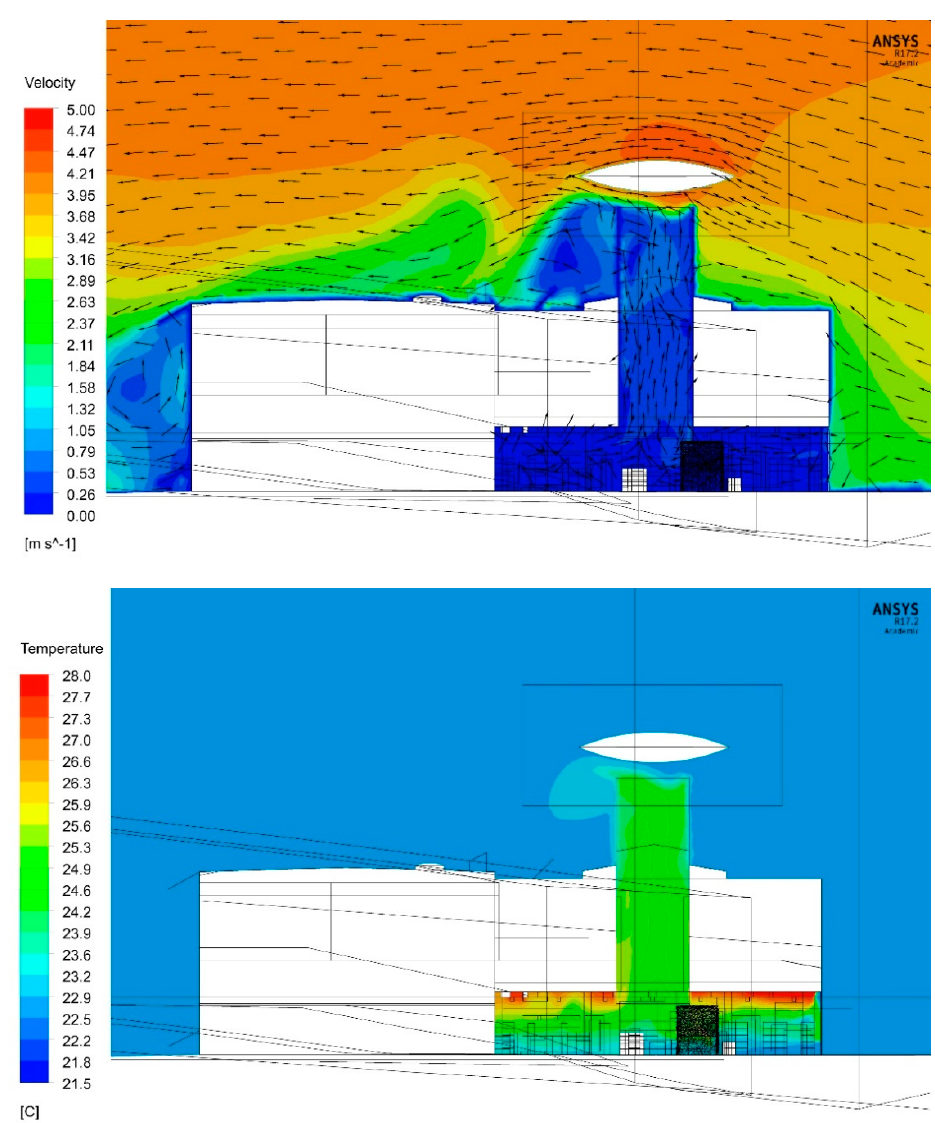
Figure 18. Cross section through the hall with velocity contours and vectors (top); air temperature distribution (bottom).